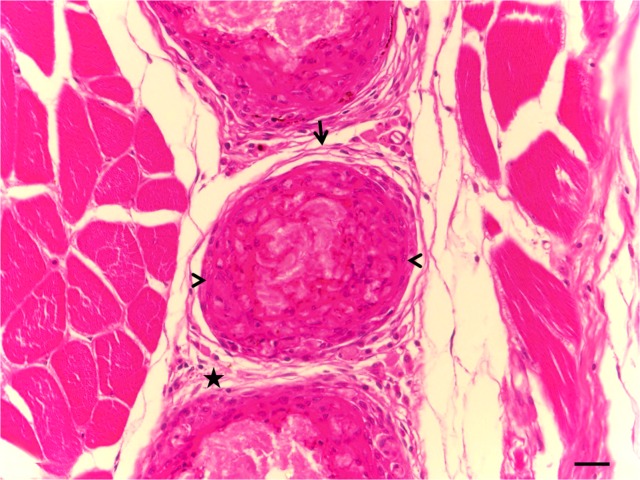
Photomicrograph of the muscle tissue of Piaractus mesopotamicus, 33 days after inoculation of BCG.Mononuclear infiltrate (star), fibroblasts arranged around the granuloma (arrow) and macrophages arranged around the inoculum (arrowhead) can be seen. (HE). Bar = 20 μm.